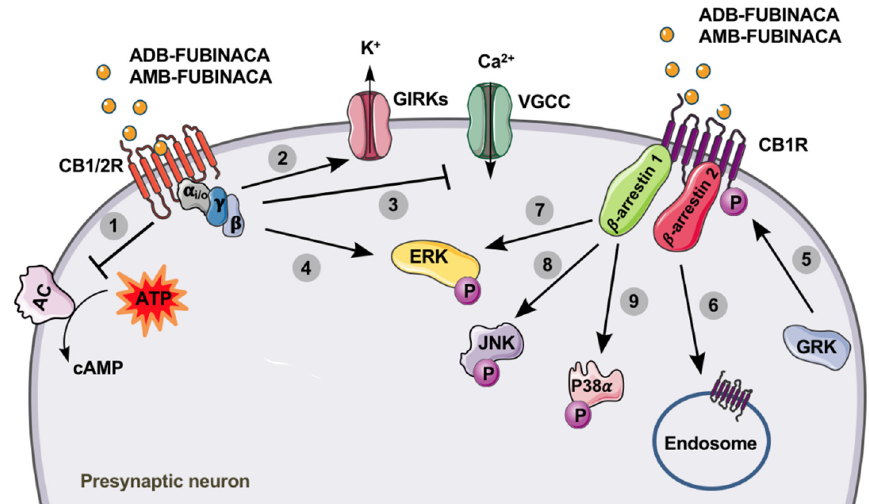
Figure 2. Cannabinoid receptors type 1 (CB1R) and 2 (CB2R) are members of the G protein-coupled receptor (GPCR) family, being associated with the G i/o type. After activation by ADB-FUNIBACA or AMB-FUBINACA (yellow circles), the activity of adenylate cyclase (AC) is inhibited (1), resulting in decreased levels of cyclic adenosine monophosphate (cAMP). Additionally, the opening of G protein-coupled inwardly-rectifying potassium channels (GIRKs) increases K + efflux (2), while the inhibition of voltage-gated calcium channels (VGCC) decreases presynaptic Ca 2+ influx (3). These events lead to the suppression of neurotransmitter release at excitatory and inhibitory synapses [108] . The binding of AMB-FUBINACA to the CB1R also results in increased extracellular signal-regulated kinase (ERK) activation (phosphorylation), through G i/o -protein-mediated signalling (4), which ultimately results in the modulation of cell proliferation, differentiation and survival. After activation of CB1R by ADB-FUNIBACA or AMB-FUBINACA, the phosphorylation of this receptor by G protein-coupled receptor kinases (GRK) can occur (5), making it highly susceptible for the binding of 𝛽 -arrestins. Consequently, receptor desensitization and internalization are stimulated (6), which is 𝛽 -arrestin 2-dependent; and a variety of signalling cascades, mostly mediated by 𝛽 -arrestin 1, are promoted, including ERK (7), c-Jun N -terminal kinase (JNK) (8) and P38 𝛼 (9) activation (phosphorylation) [109,110] .